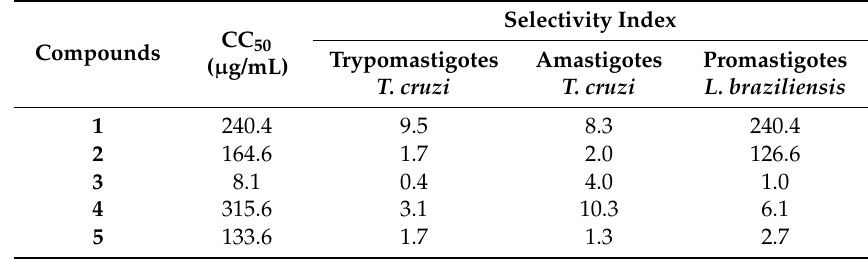
Table 1. Cytotoxicity on Vero cells and selectivity indexes of estafietin ( 1 ) and estafietin derivatives ( 2 – 5 ).